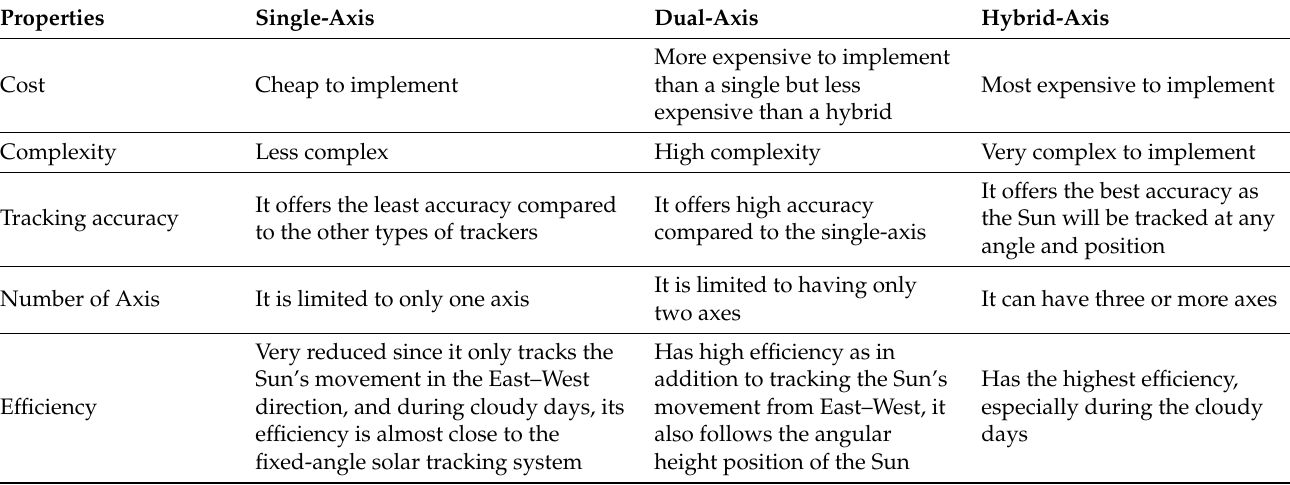
Table 1. Comparison between the Solar Tracking System based on Axis